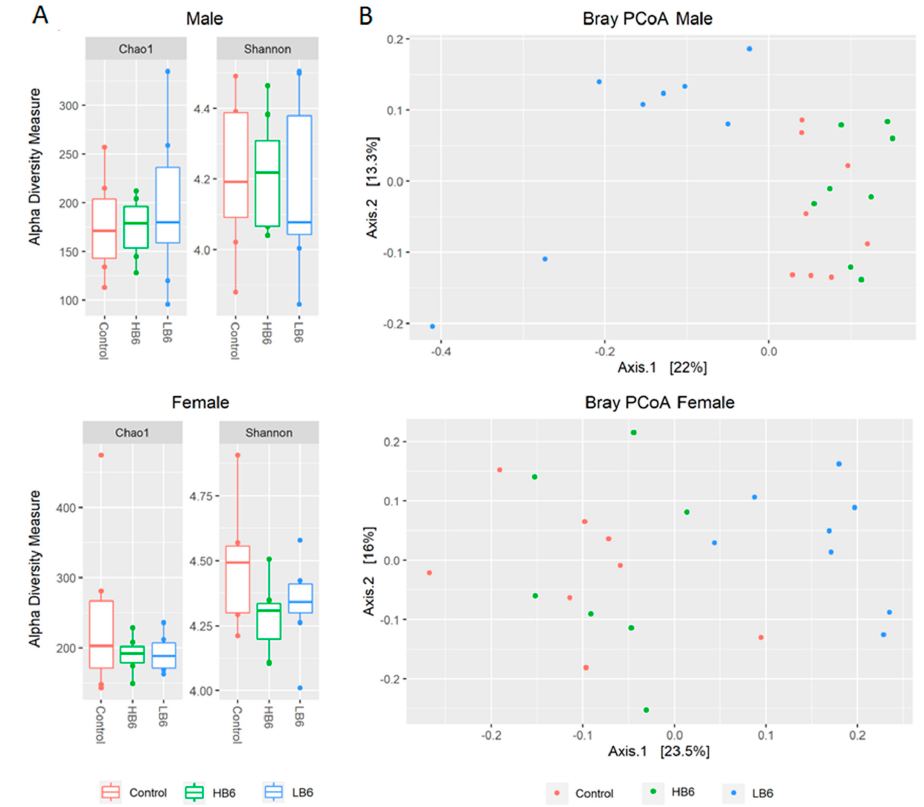
Figure 2. Changes in gut bacteria community composition due to variable levels of vitamin B6 expressed as alpha-diversity ( A ) and beta-diversity ( B ). Alpha-diversity was not significant (Kruskal–Wallis test for α -diversity for male rats (Chao1: p = 0.72, Shannon: p = 0.88) and female rats (Chao1: p = 0.77, Shannon: p = 0.20); while beta-diversity according to the Bray–Curtis model was significant ( p < 0.001 for both sexes), n = 7–8/group of each sex).